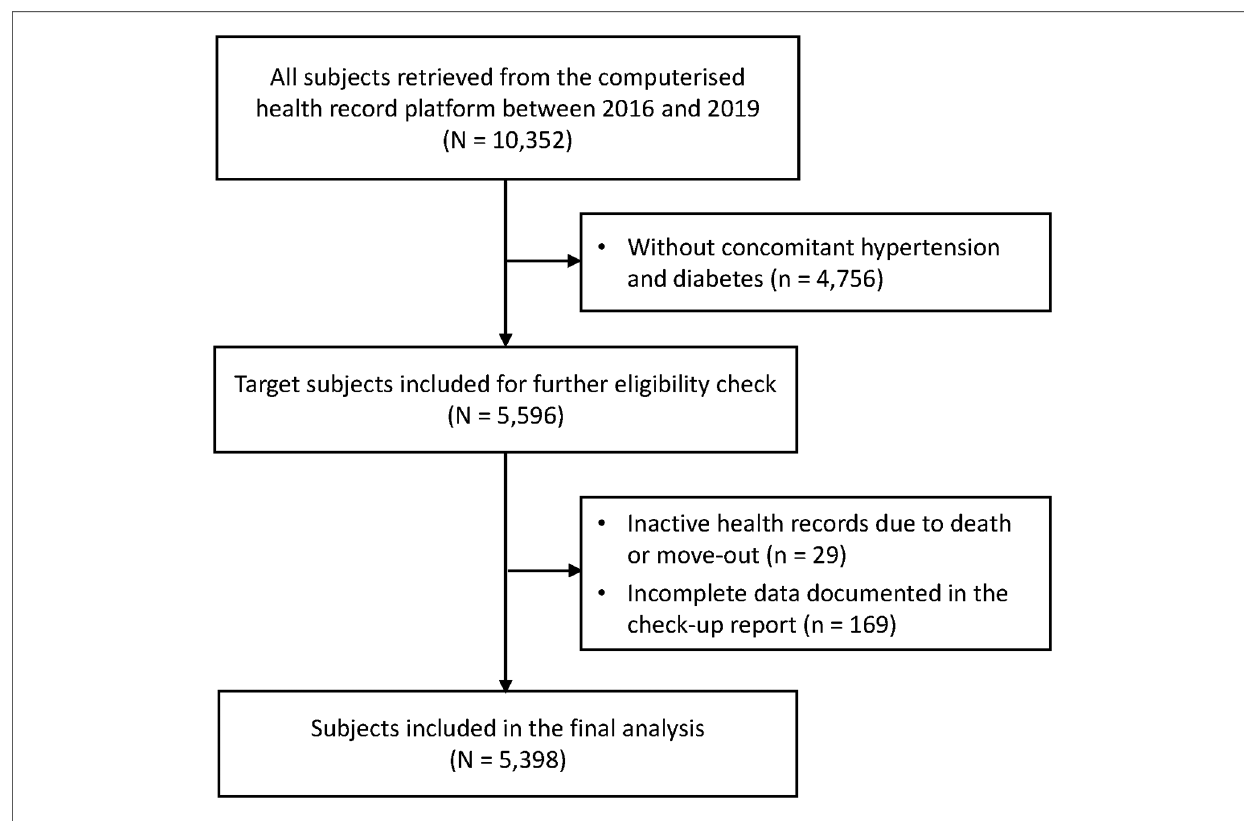
FIGURE 1 Diagram of study fl